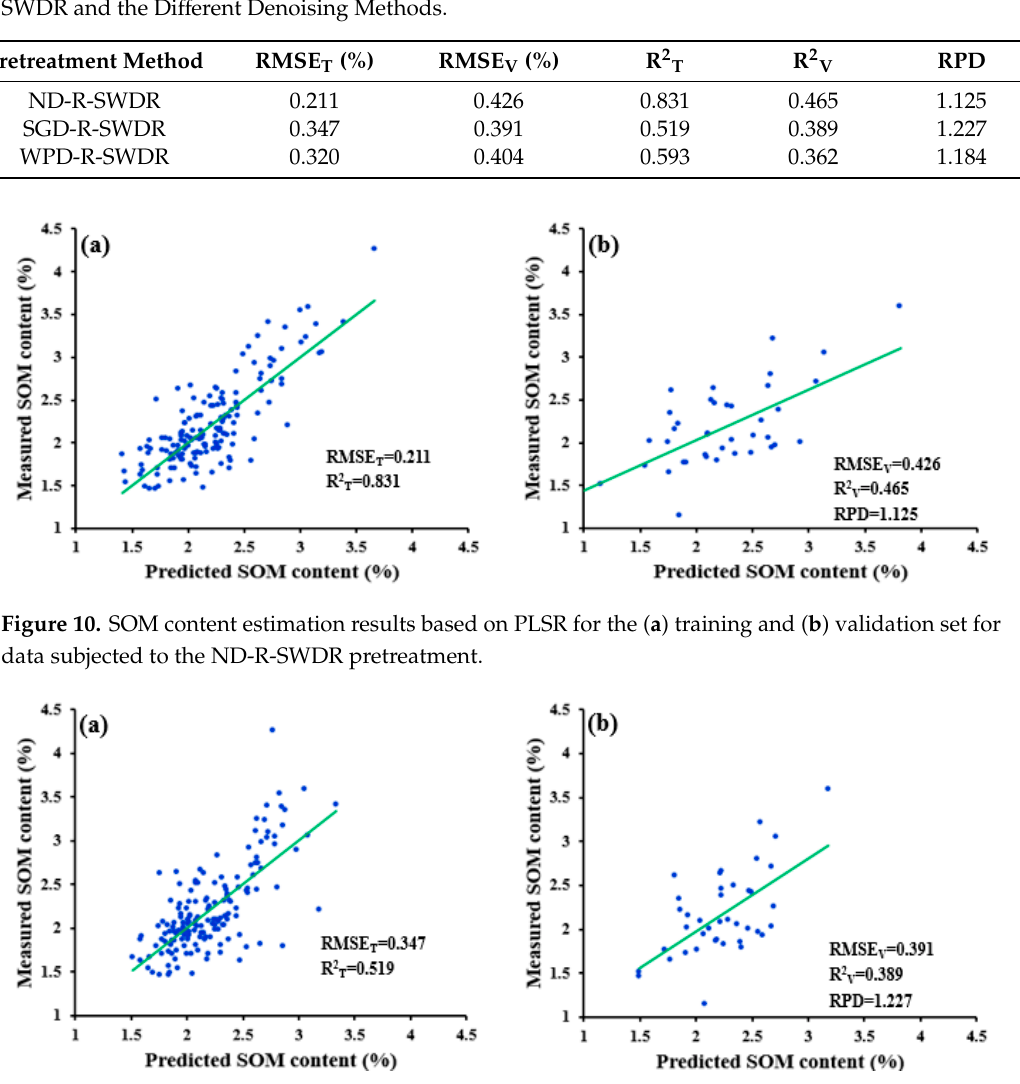
Figure 11. SOM content estimation results based on PLSR for the ( a ) training and ( b ) validation set for data subjected to SGD-R-SWDR pretreatment.